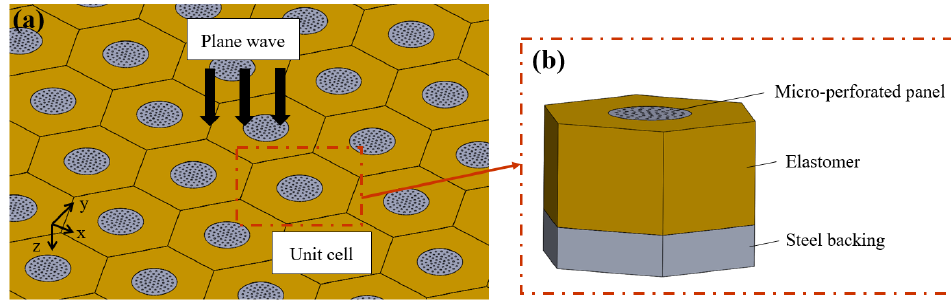
Figure 1. Schematic of developed hybrid sound-absorbing metastructure: ( a ) configuration and problem description and ( b ) unit cell of the metastructure.